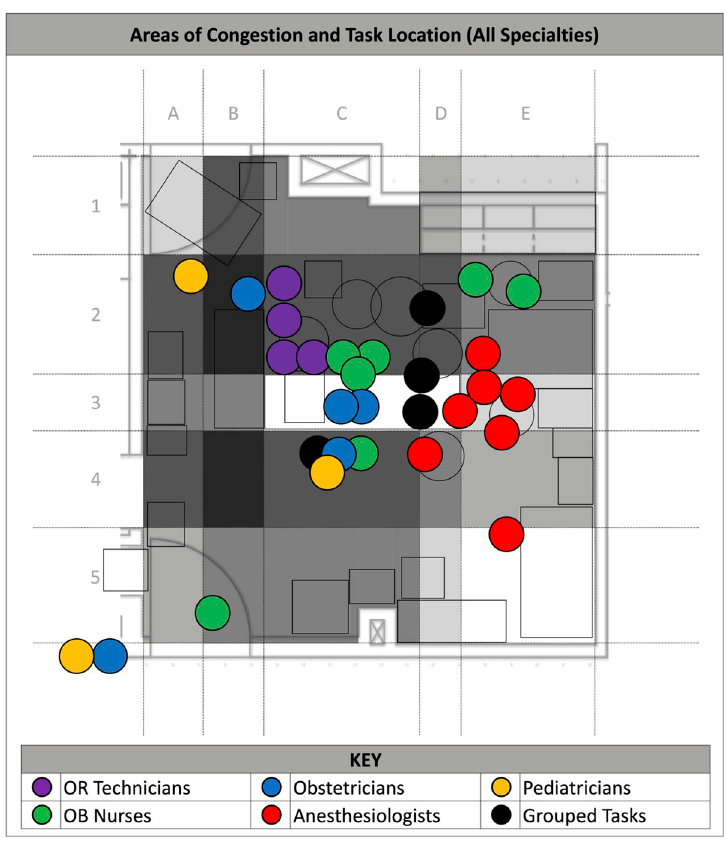
Fig 4. Overlay of reported areas of congestion and task location in OR-B. Non-shaded areas indicate no reports of congestion. Increasing degrees of shading correlate with increasing reports of congestion by one or more specialties. Colored dots indicate task groupings color coded by